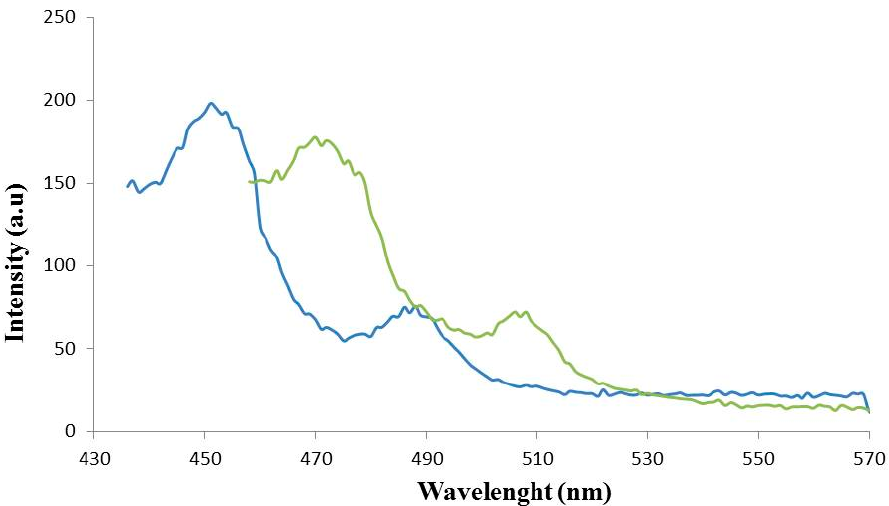
Figure 3. Experimental emission spectra of 1 (blue line) and 2 (green line). Horizontal axis: wavelength (nm); vertical axis: intensity (arbitrary units, a.u.).